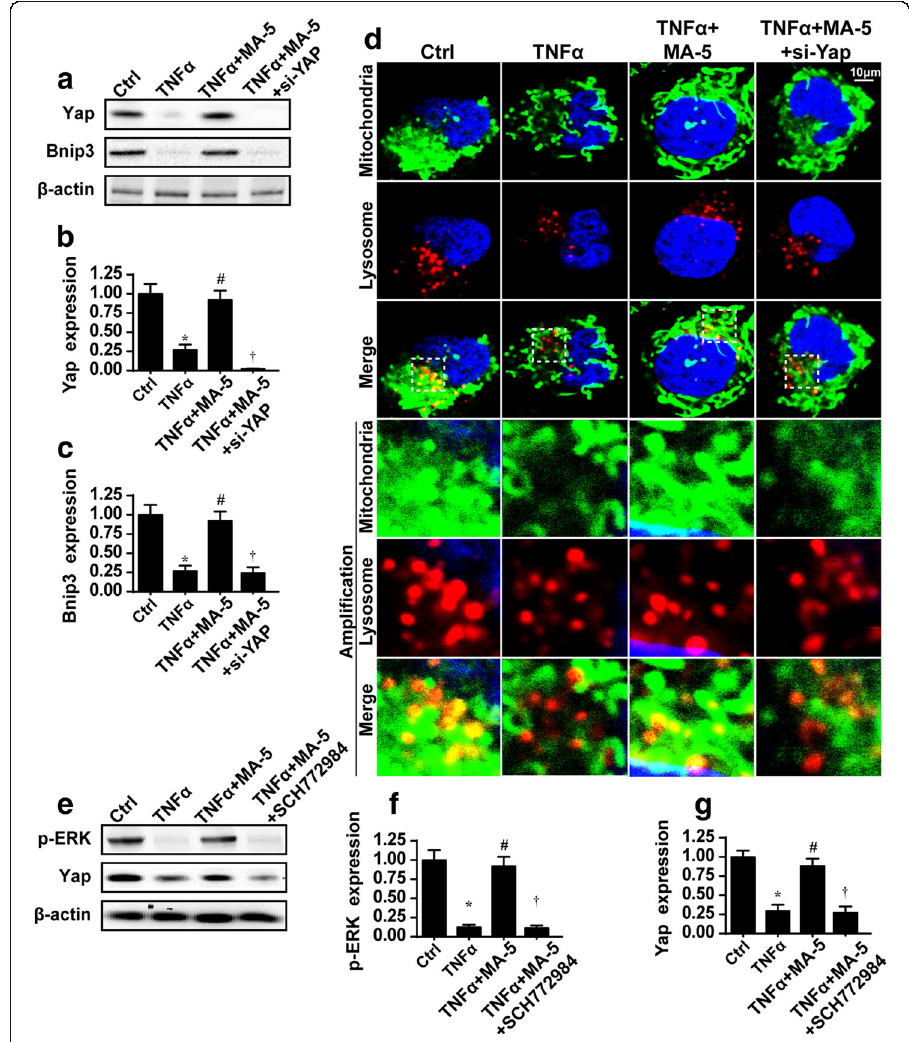
Fig. 5 MA-5 regulated the Bnip3-related mitophagy via the MAPK – ERK – Yap pathways. a through c Western blotting was used to analyze the changes in Yap and Bnip3. siRNA was used to silence Yap expression (si-YAP), which also reduced the expression of Bnip3. d The immunofluorescence assay of mitophagy via mitochondria and lysosome co-staining. The Yap siRNA also reduced the mitophagy. e through g SCH772984 was used to inhibit ERK activity. The ERK inhibitor also reduced Yap expression. * p <0.05 vs. control (Ctrl) group; # p <0.05 vs. TNF α group; † p <0.05 vs. TNF α +MA-5